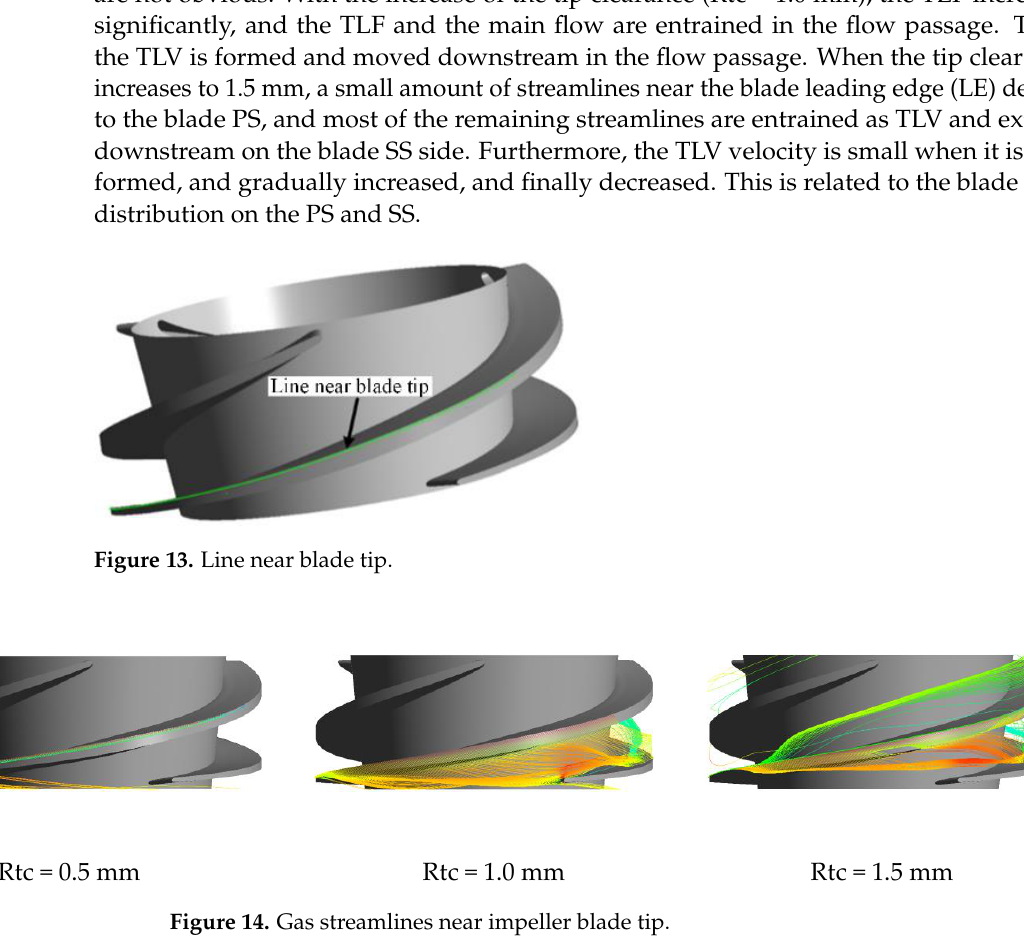
Figure 12. Gas distribution in the impeller and diffuser meridian plane.